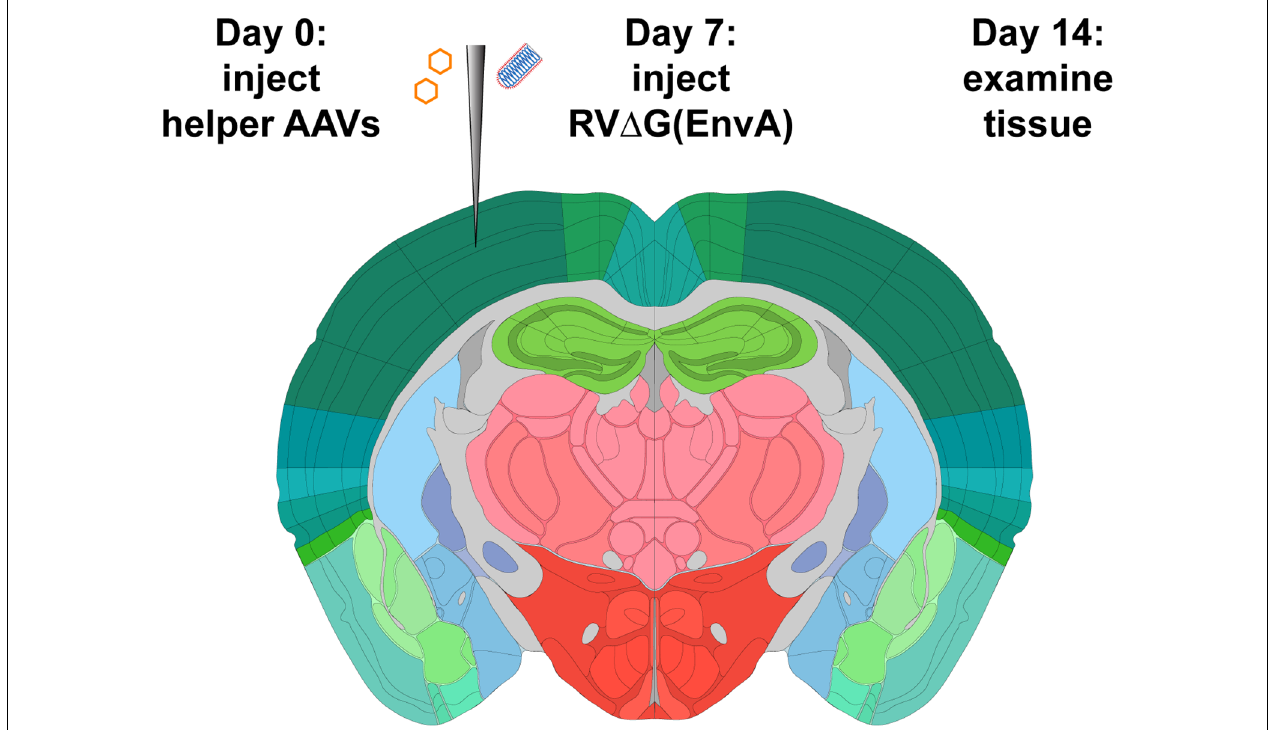
FIGURE 1 | Strategy for monosynaptic tracing with helper adeno-associated viral vectors (AAVs). Helper viruses are injected in a Cre mouse, or a Cre-negative mouse in the case of control experiments, then rabies virus (RV; ∆ G, EnvA-coated, expressing mCherry) is injected in the same location subsequently. While different labs have used various intervals and survival times, we used a 7-day interval between AAV and RV injections, and another 7-day interval between RV injection and perfusion, in all experiments for this article. Brain image adapted with permission from the Allen Mouse Brain Atlas.